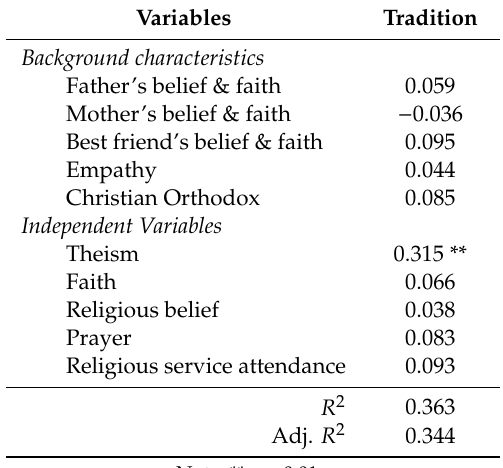
Table 7. Regression analysis for traditionalism with weights ( β ) for each variable and total explained variance ( R 2 and adjusted R 2 ).